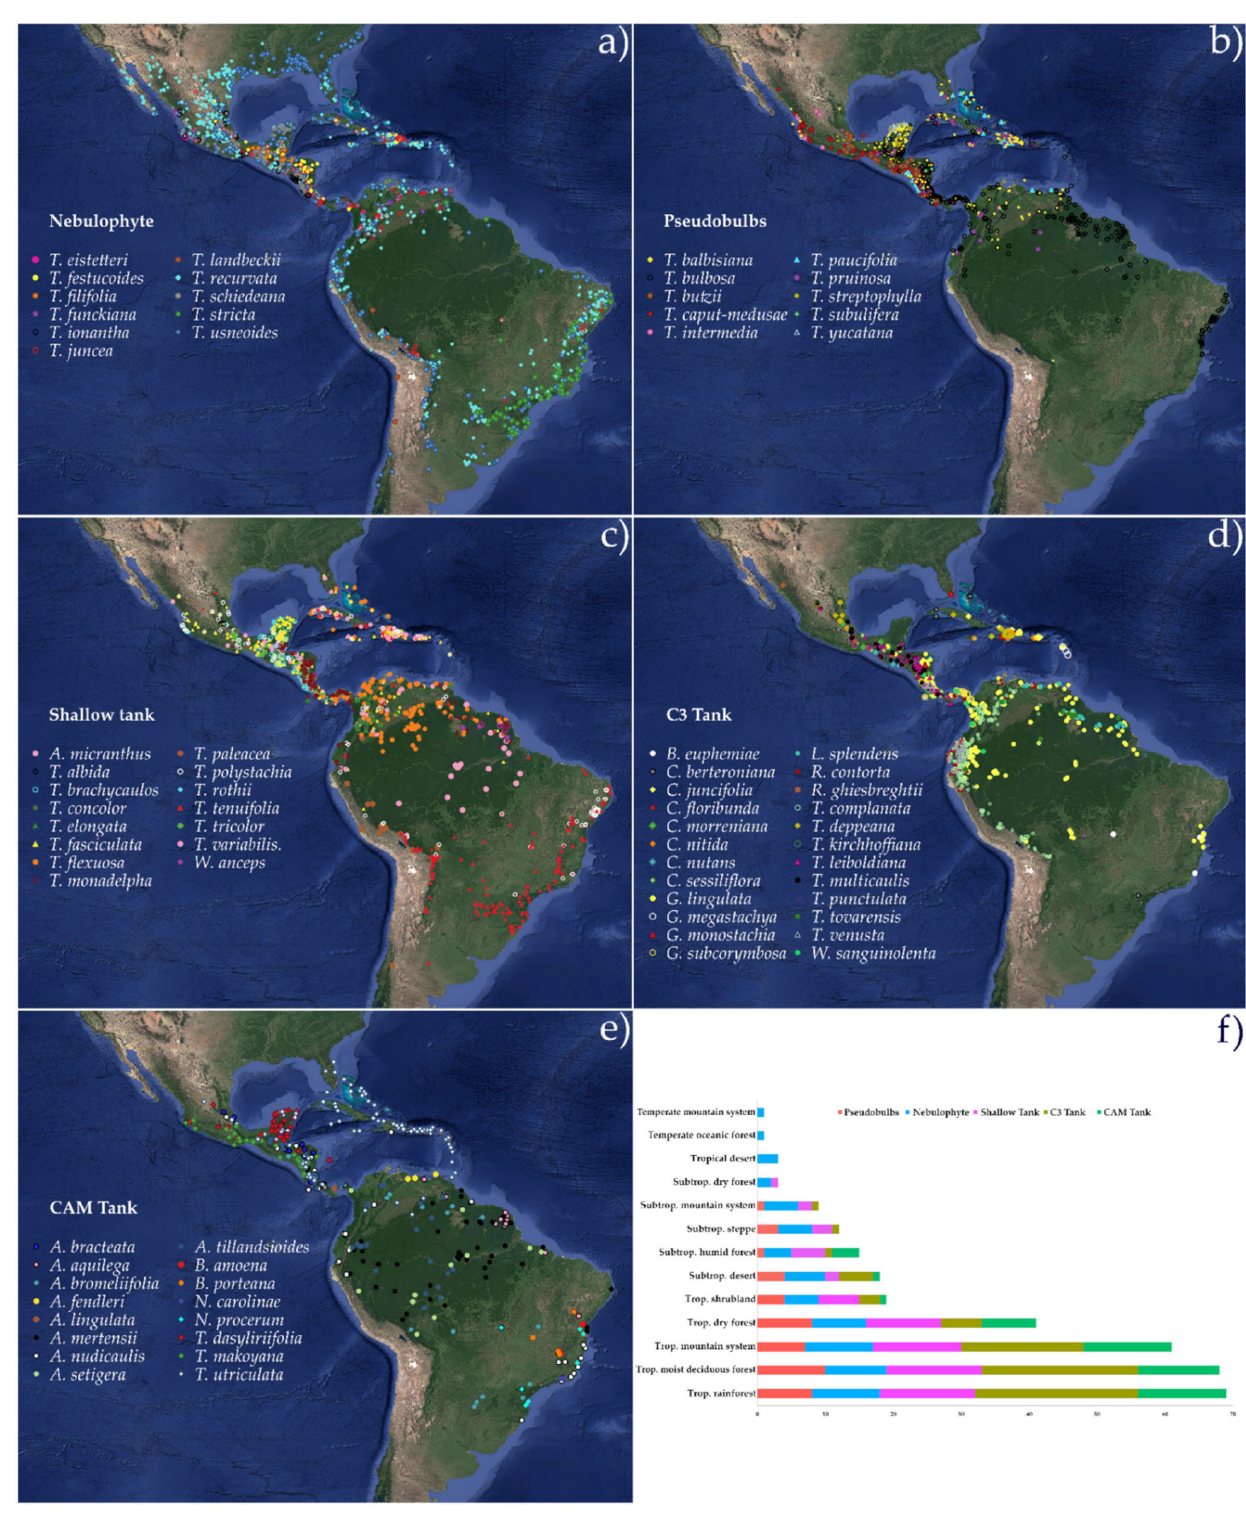
Figure 6. Geographical distribution of the functional groups: ( a ) nebulophytes; ( b ) pseudobulbs; ( c ) shallow tanks; ( d ) C 3 tanks; ( e ) CAM tanks, and ( f ) species richness per functional groups in ecological zones